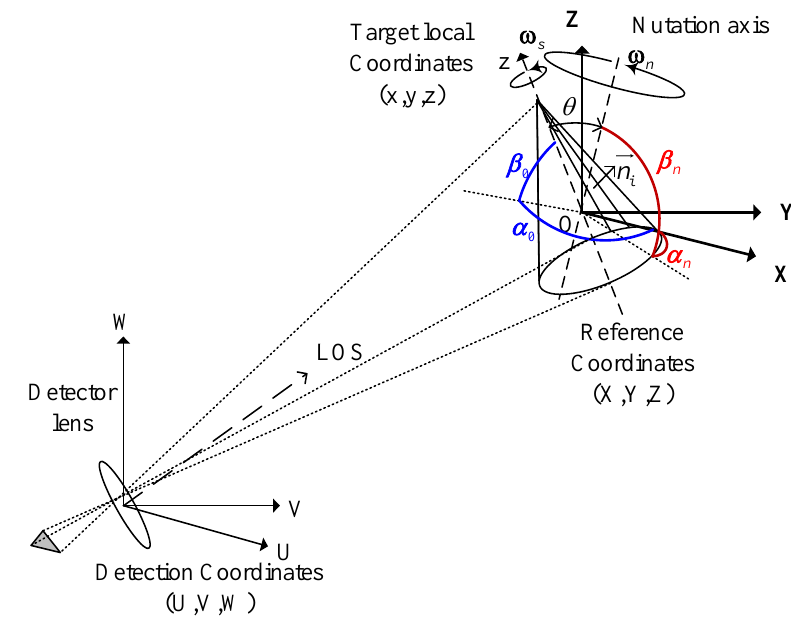
Figure 1. Geometry of IR sensor and a target with nutation, where the IR detection coordinates are parallel to the reference coordinates.